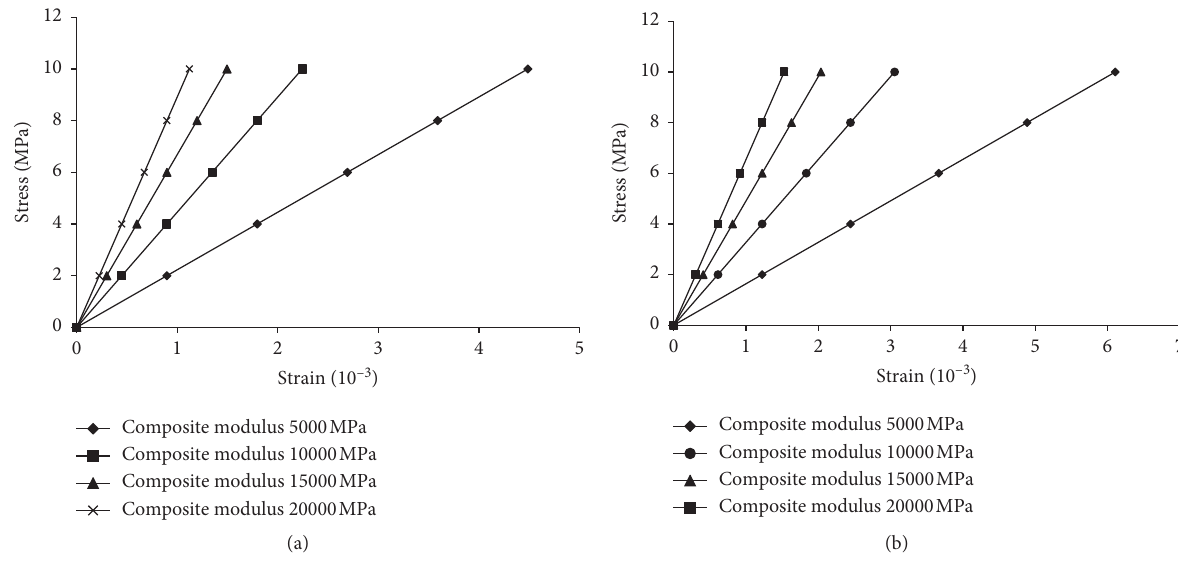
Figure 13: Variation of stress-strain curve of simulation model with composite modulus of aggregate-cement paste material: (a) specimen 1#; (b) specimen